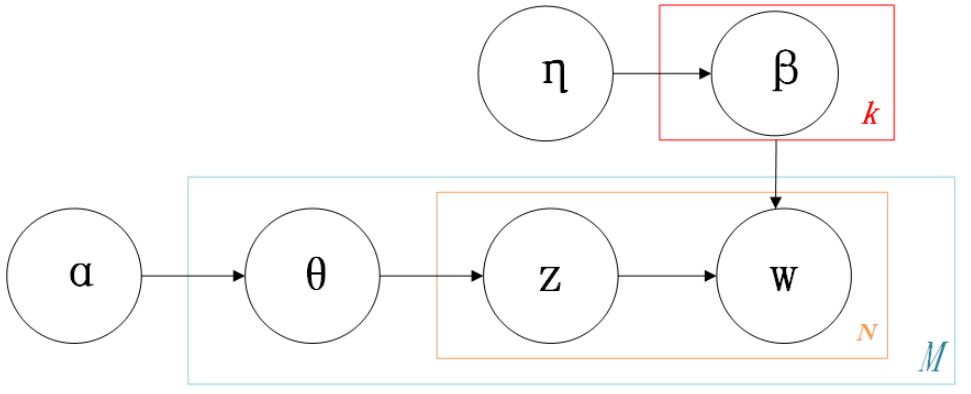
Figure 6. LDA topic model structure diagram.